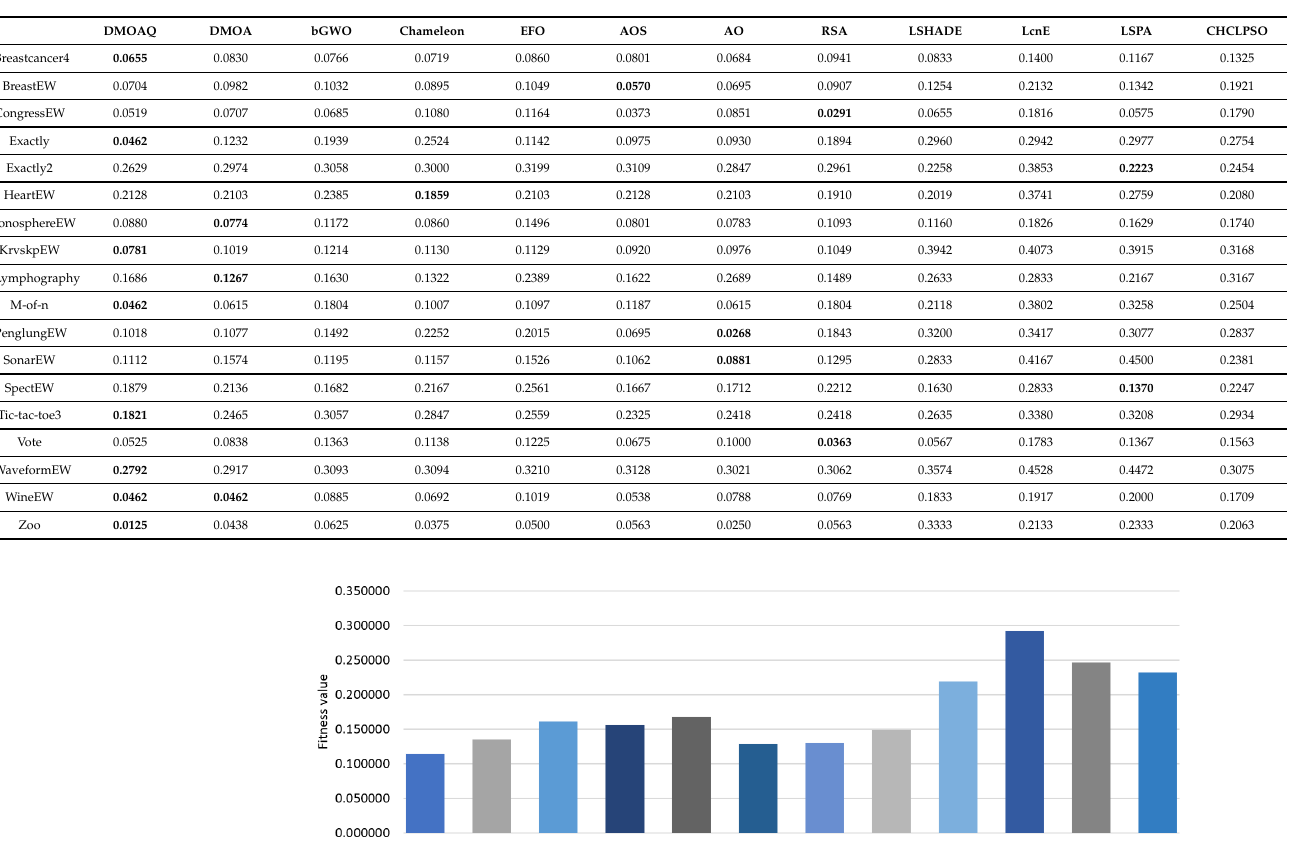
Table 6. Maximum of the fitness function values.